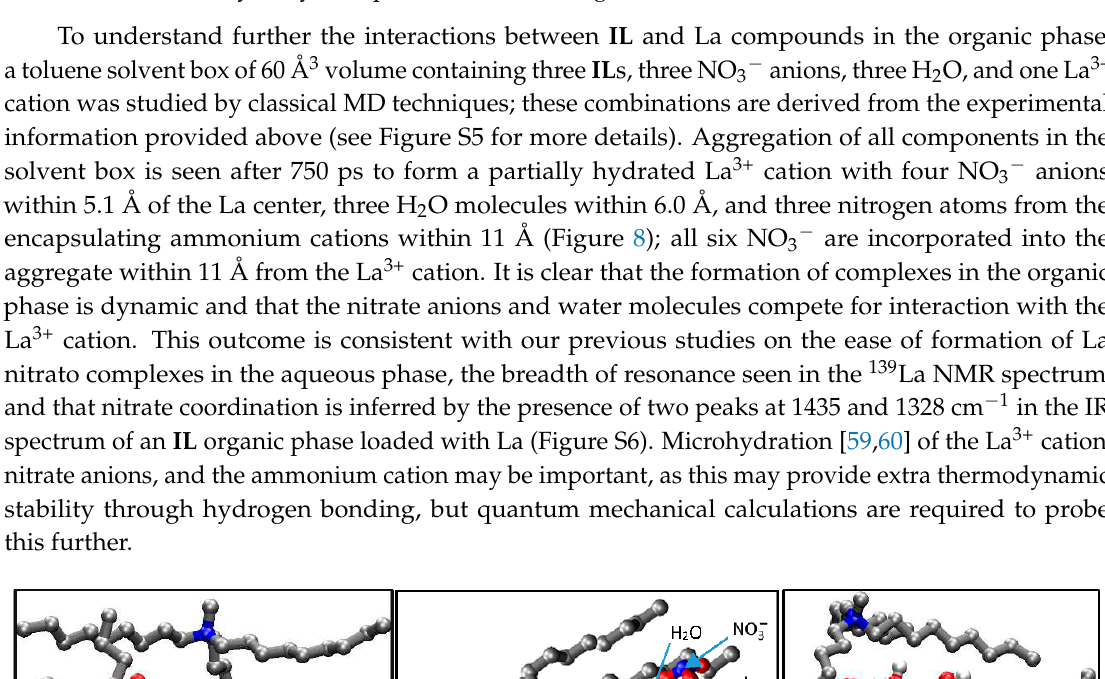
Figure 7. 139 La NMR spectra of the La standard, LaCl 3 (0.01 M, 0.0 ppm) in D 2 O (red) and the IL organic phase (0.05 M) after contact with a 0.05 M aqueous La solution extraction IL (blue).